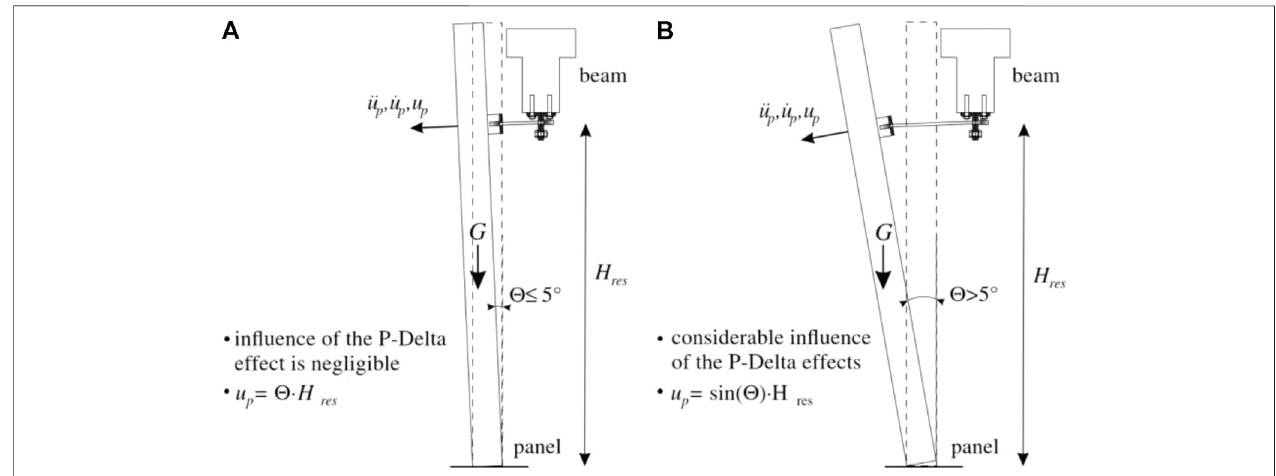
FIGURE13|(A) :Smallinclination ofthepanelinthecaseofshortrestrainers — theP – Δ effectisnegligible. (B) :Signi fi cantinclination ofthepanelinthecaseoflong restrainers — the P – Δ effect should be taken into account [adopted from Zoubek et al. (2016b)].